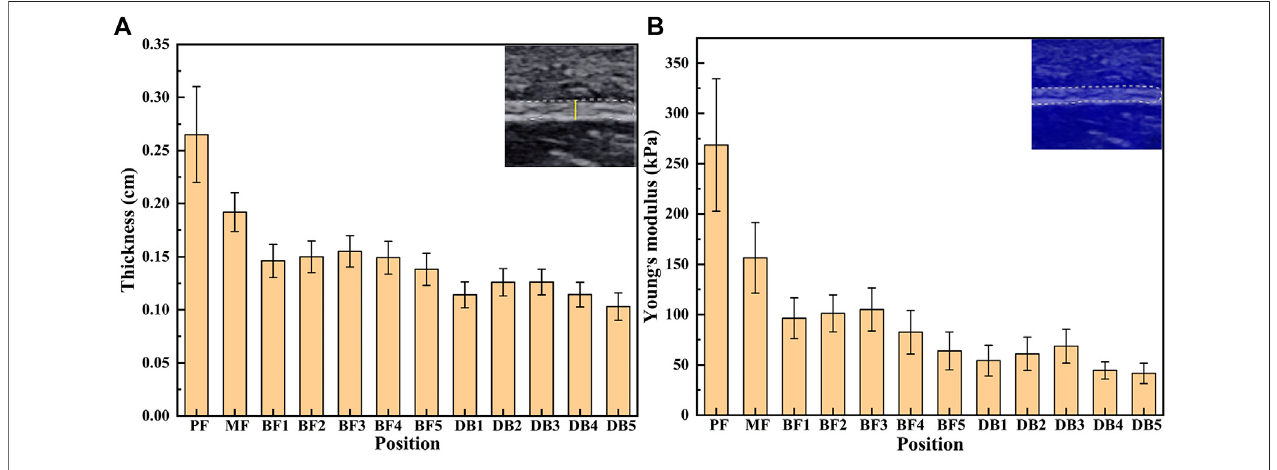
FIGURE 3 | The thickness (A) and Young ’ s modulus (B) of plantar fascia of 15 fl exible fl atfeet.